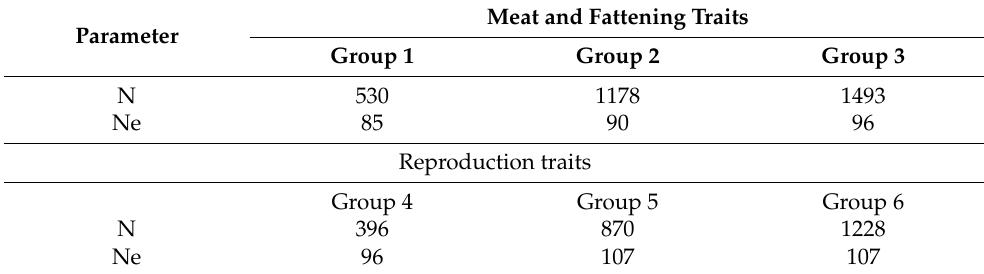
Table 3. Reference groups